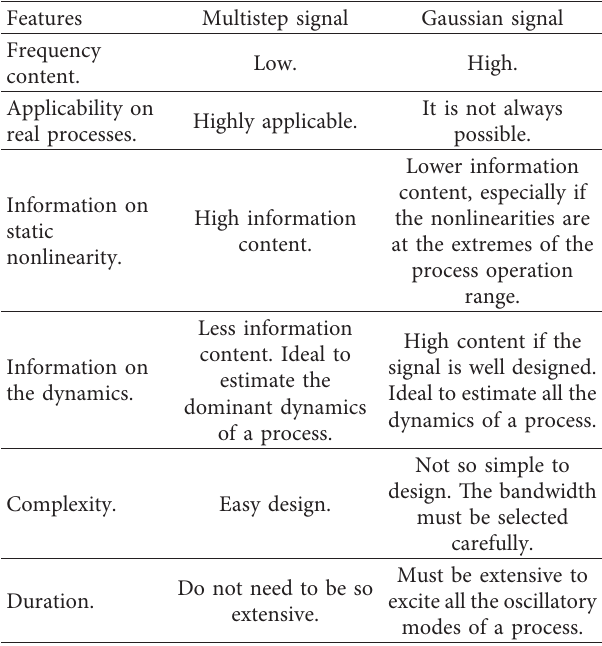
Table 2: Comparison of characteristics between a multistep signal and a Gaussian